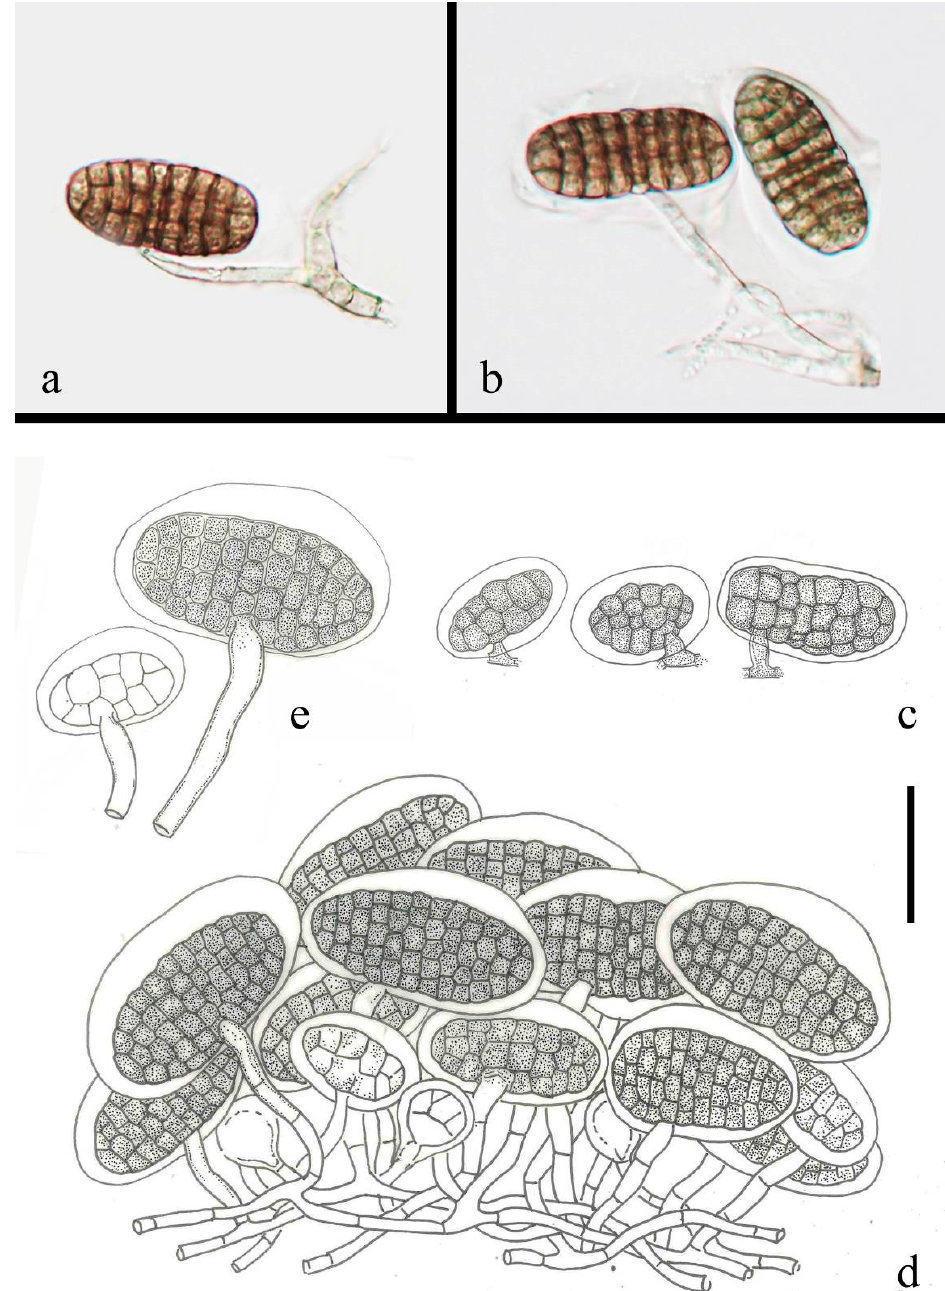
Figure 4. Coleodictyospora spp. ( a , b from MFLU 18-1544, holotype. c – e redrawn from Matsushima [31] and Seifert et al. [42]). ( a , b ) C . muriformis (conidia with branched conidiophores); ( c ) C. micronesica (conidia growing on a short subulate conidiogenous cell which directly ascends from the basal mat of sporodochia); ( d , e ) C. cubensis (d sporodochia bearing a mass of conidia. e conidia with a long conidiogenous cell). Scale bars, ( a – e ) 30 μ m.